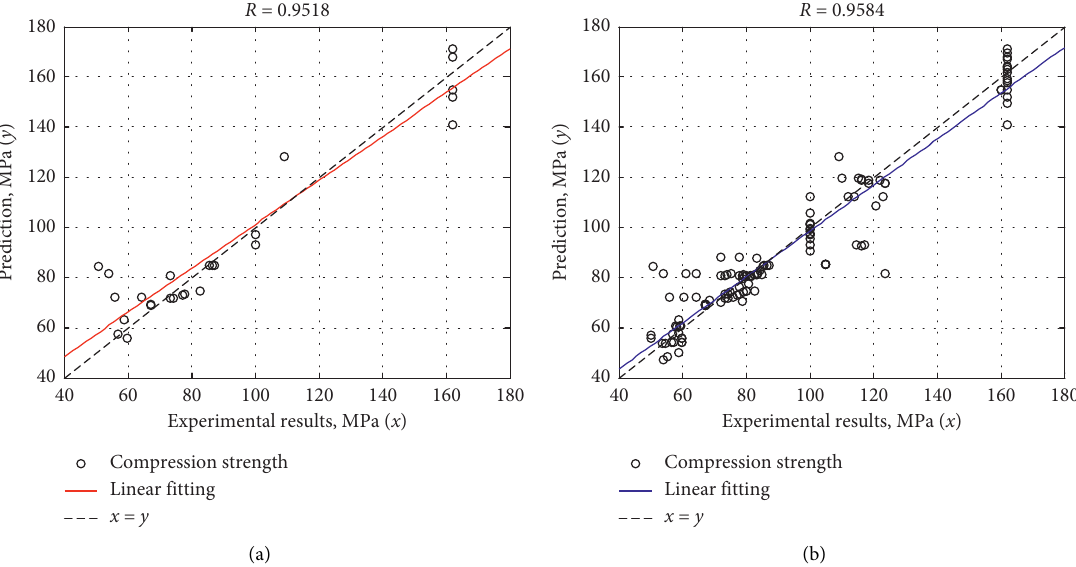
Figure 10: Linear regression plot of ANFIS performance. (a) Testing. (b) Overall.